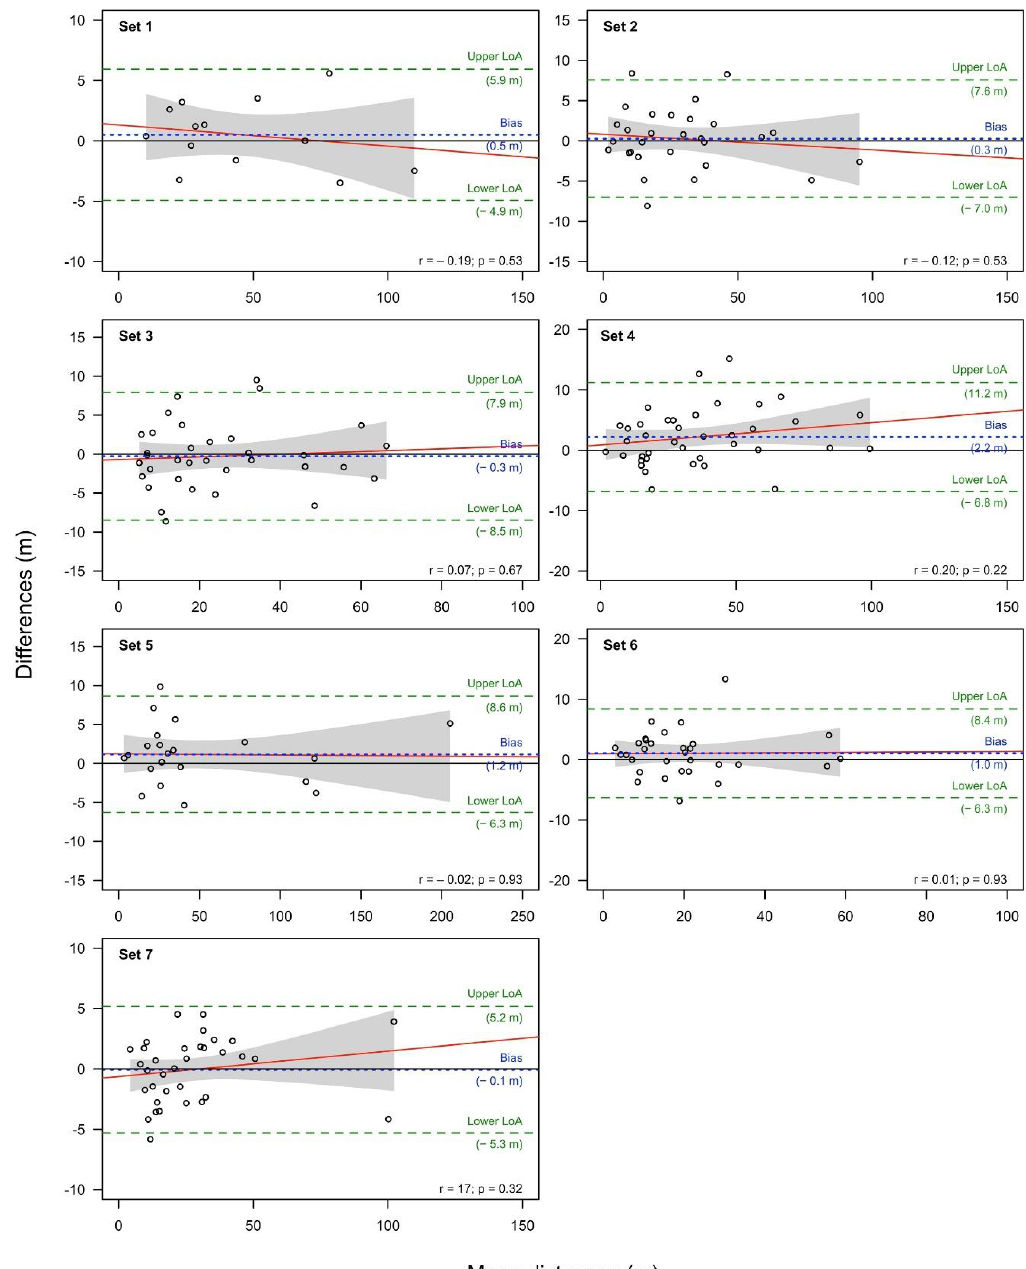
Figure 3. Results of the Bland – Altman analysis and linear regression for the datasets, including distances between subsequent points (nests). Note: the red line shows the regression between bias and mean differences.